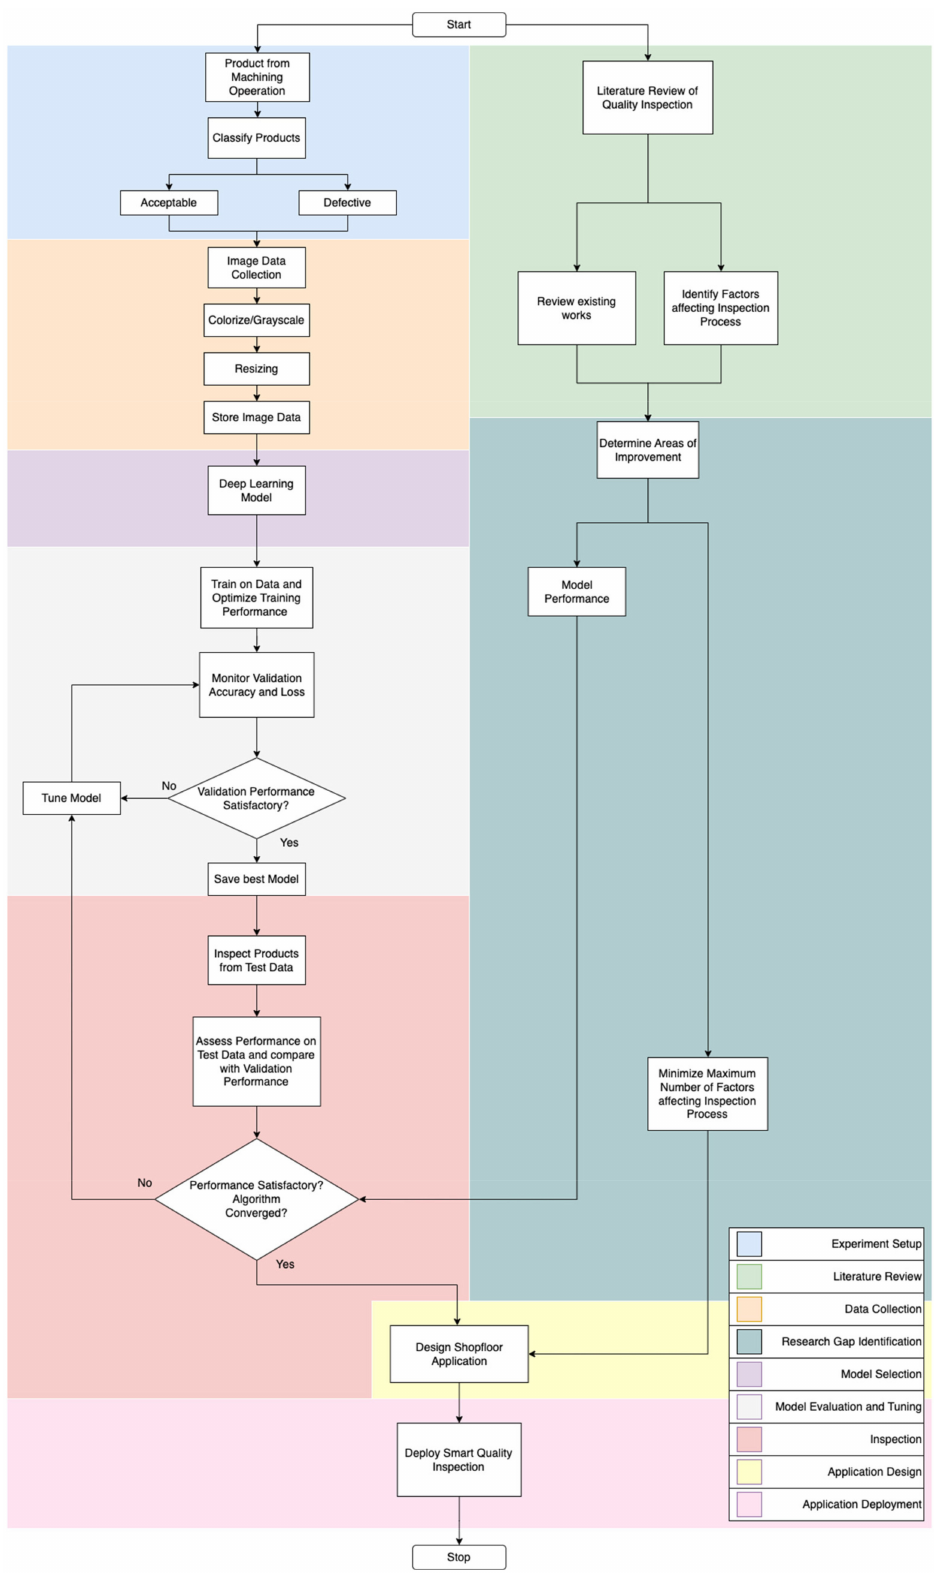
Figure 2. Flowchart depicting the process used to develop Smart Quality Inspection—algorithm construction and identification of research gap via literature